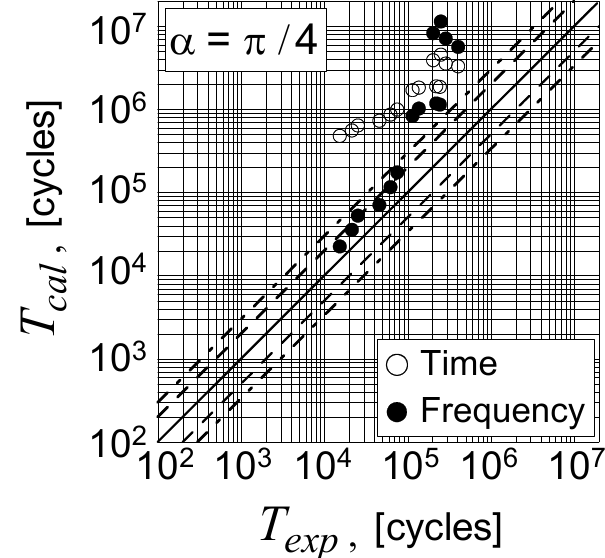
4: Comparison between experimental and Figure 5: Comparison between experimental and theoretical fatigue lives ( /8    ), the latter determined theoretical fatigue lives ( / 4    ), the latter determined by employing: the frequency domain criterion here the time domain proposed (see solid symbols) and the time domain criterion reported in Ref. [4] (see hollow symbols). criterion reported in Ref. [4] (see hollow